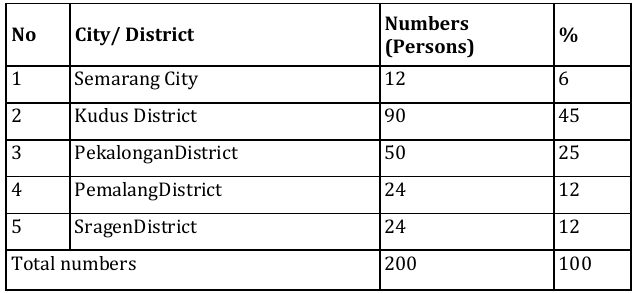
Table 4: The Distribution Of Convection Respondents In Central Java